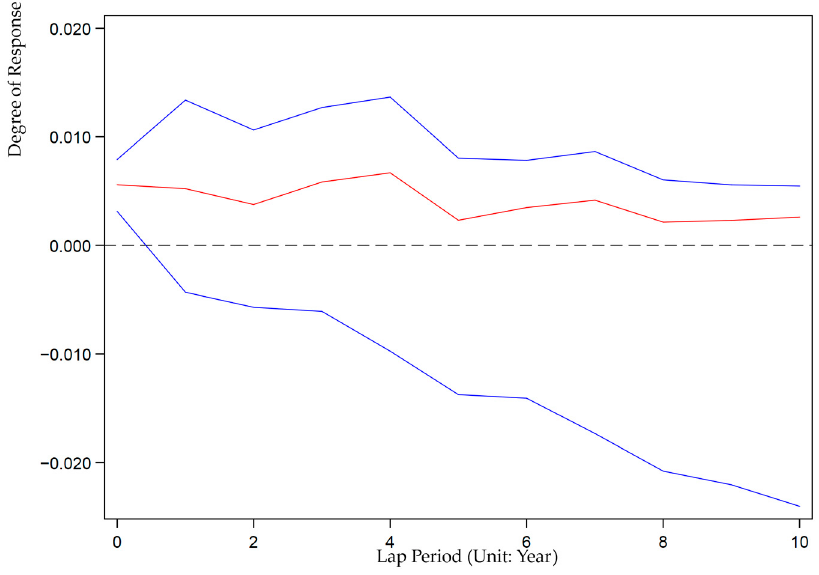
Figure 4. Impulse response of GEE to ULDI.